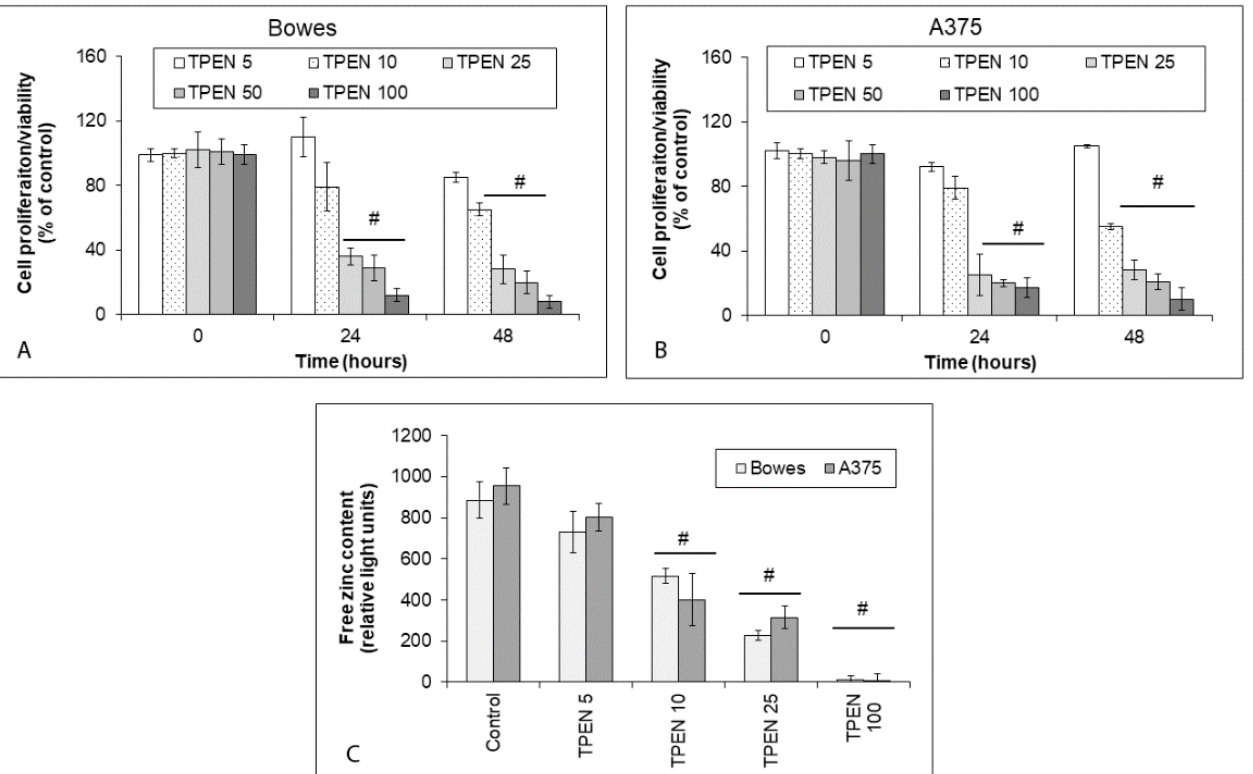
Figure 2. The proliferation and free zinc in human melanoma Bowes and A375 cell lines exposed to intracellular zinc chelating TPEN. Cells were exposed to TPEN at the concentration range of 5–100 µM during 48 h and their proliferation was determined by ( A , B ) colorimetric WST-1 assay. Values represent means ± SD of at least three experiments. p < 0.05 # Significantly lower than control at the same treatment interval with a one-way-Anova test and Dunnett’s post test for multiple comparisons. ( C ) Free (labile) zinc in melanoma cells as measured by microfluorimetry. Values represent means ± SD of at least three experiments. p < 0.05 # Significantly lower than control cells at the same treatment interval with a one-way-Anova test and Dunnett’s post test for multiple comparisons.